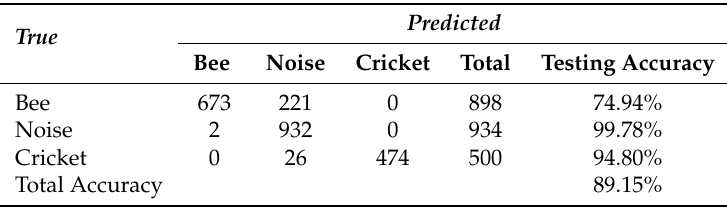
Table 15. Confusion matrix for logistic regression on BUZZ2 testing dataset.